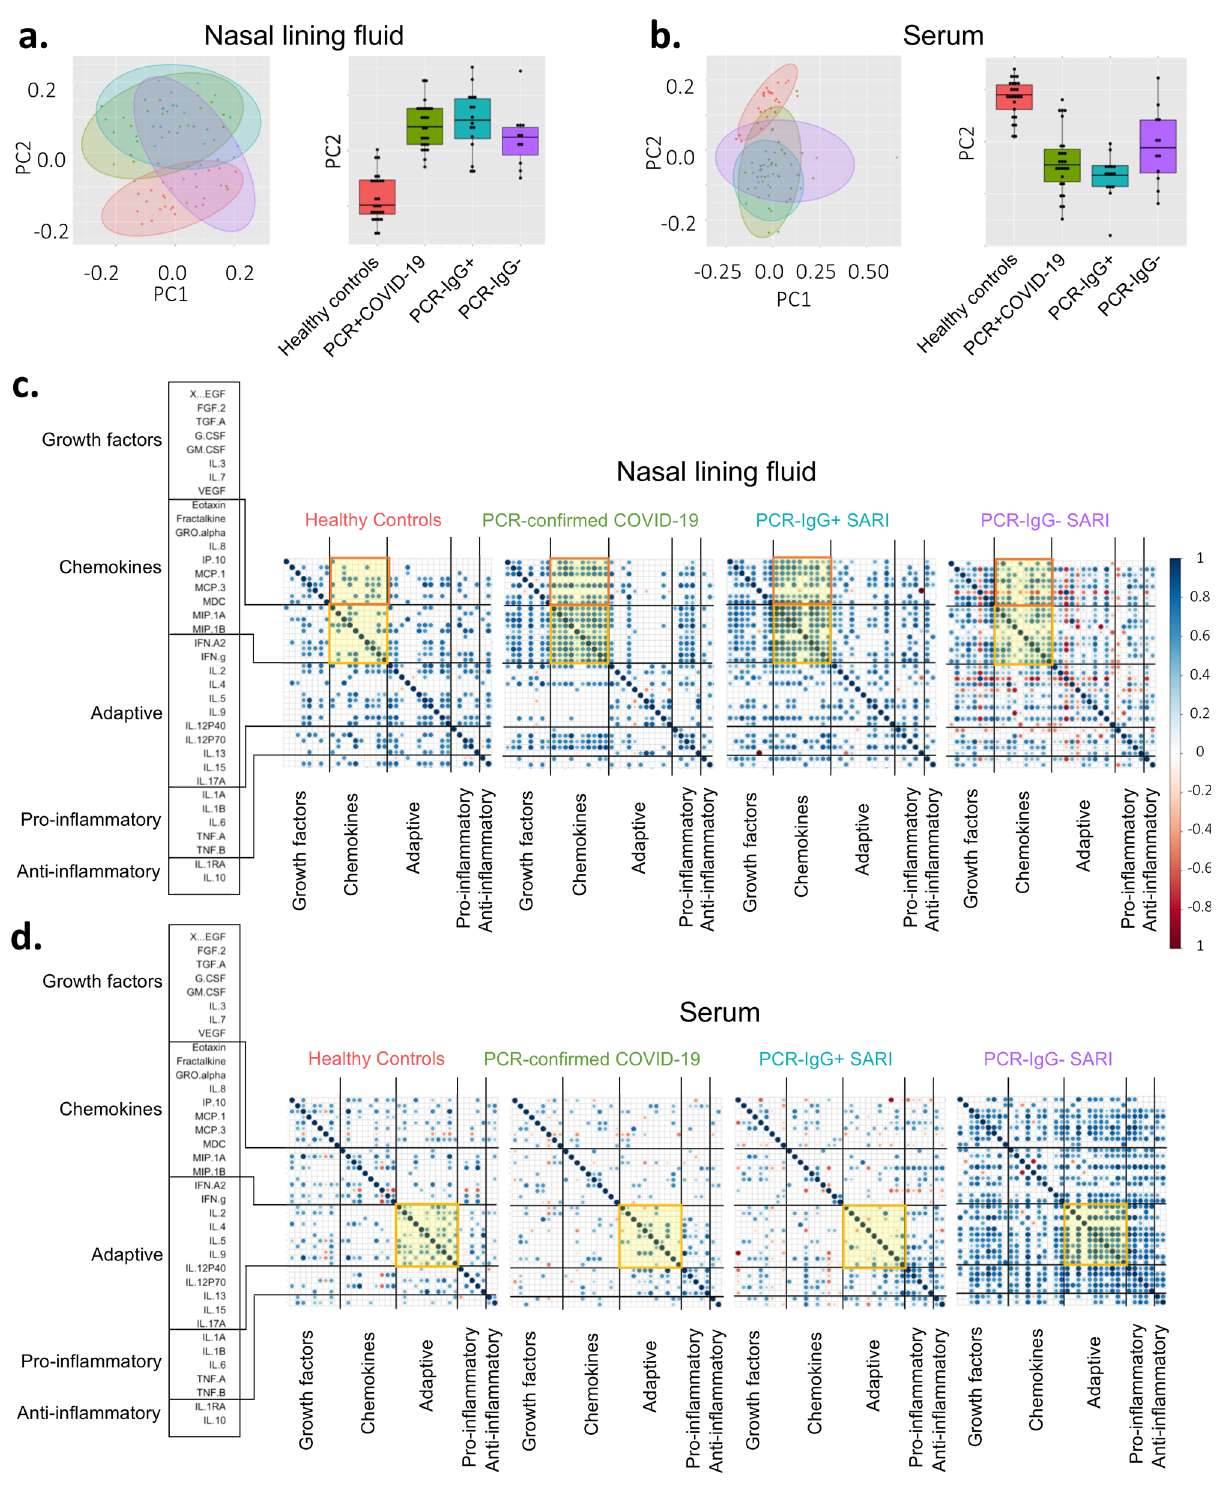
Fig. 3 Nasal and serum cytokine pro fi les. Principal component analysis (PCA) of the 38 analytes (37 cytokines and sCD40L) in a nasal lining fl uid and b serum of healthy controls, PCR-con fi rmed COVID-19, PCR − /IgG + SARI and PCR − /IgG − SARI patients, showing similarity of nasal cytokine responses between PCR-con fi rmed COVID-19 and PCR − /IgG + SARI patients. Correlogram of cytokine interactions in c nasal lining fl uid and d serum among the different study groups, showing induction of similar immune process in PCR-con fi rmed COVID-19 and PCR − /IgG + SARI patients. For all boxplots, box boundaries correspond to 25th and 75th percentiles; whiskers extend to a maximum of 1.5× the interquartile range, with values outside the box and whiskers being outliers. Healthy controls, n = 25; PCR-con fi rmed COVID-19, n = 25; PCR − /IgG + SARI, n = 16; PCR − /IgG − SARI, n = 11. SARS-CoV-2 severe acute respiratory syndrome coronavirus 2, COVID-19 coronavirus disease of 2019, PCR polymerase chain reaction, IgG immunoglobulin G, SARI severe acute respiratory infection, PC1 principal component 1, PC2 principal component 2. Source data are provided as a Source Data fi le.